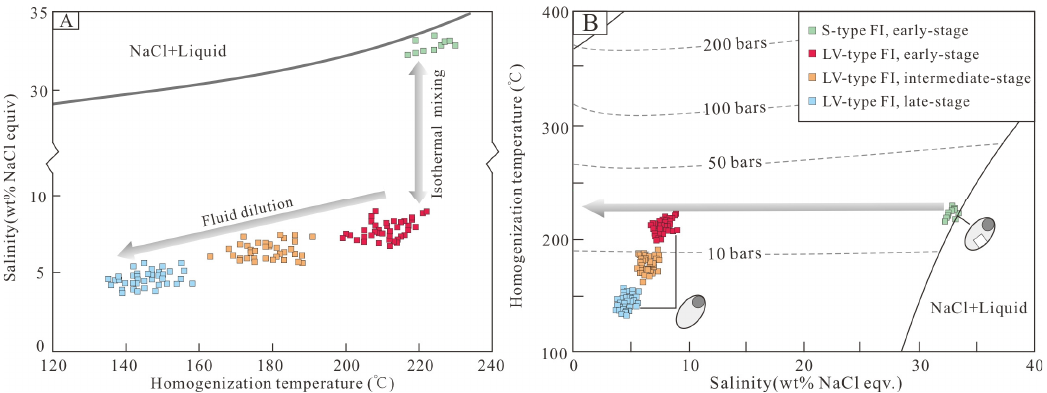
Figure 7. ( A ) T h vs. salinity in the NaCl–H 2 O system, and ( B ) pressure estimates for FIs of the Harla gold deposit. Isobars were calculated using the equations of Driesner and Heinrich [24].